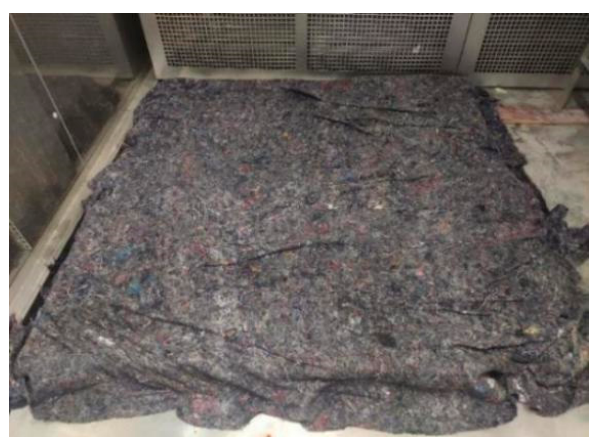
Figure 1. Environmental chamber.